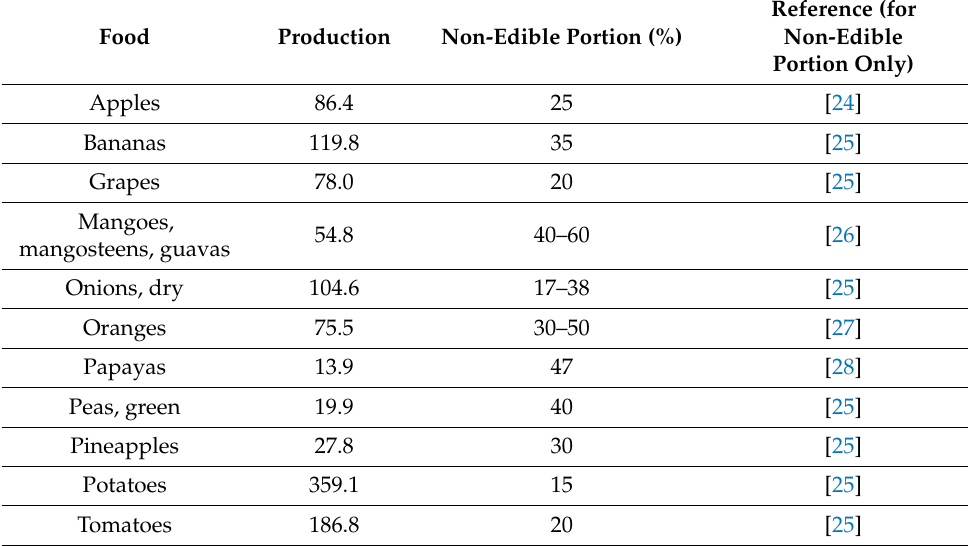
Table 3. Worldwide annual production volumes of some fruits and vegetables in 2020, and the concentration of their non-edible portion (%) as potential by-product streams (Mt: million tons), (Source for production: [22]).